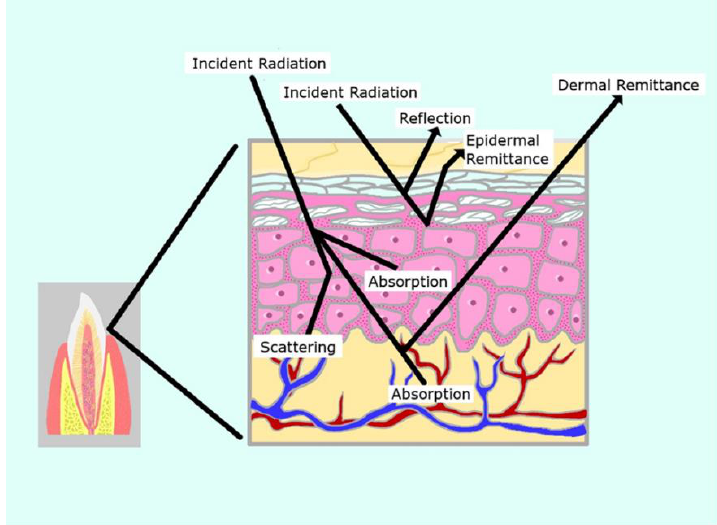
Figure 3. Outcomes of optical transport at a target tissue result in significant energy loss (radiant exitance).